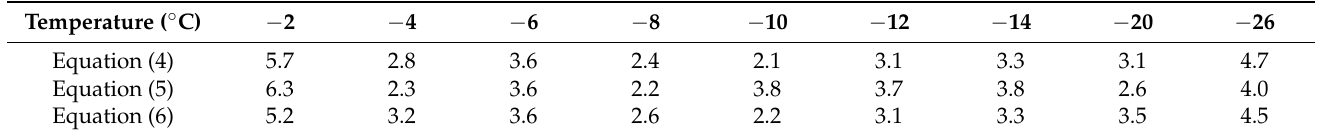
Table 7. Maximum difference between the unfrozen water content determined by the DSC method at a given negative temperature and the unfrozen water content predicted by the empirical models 4–6, expressed in % by